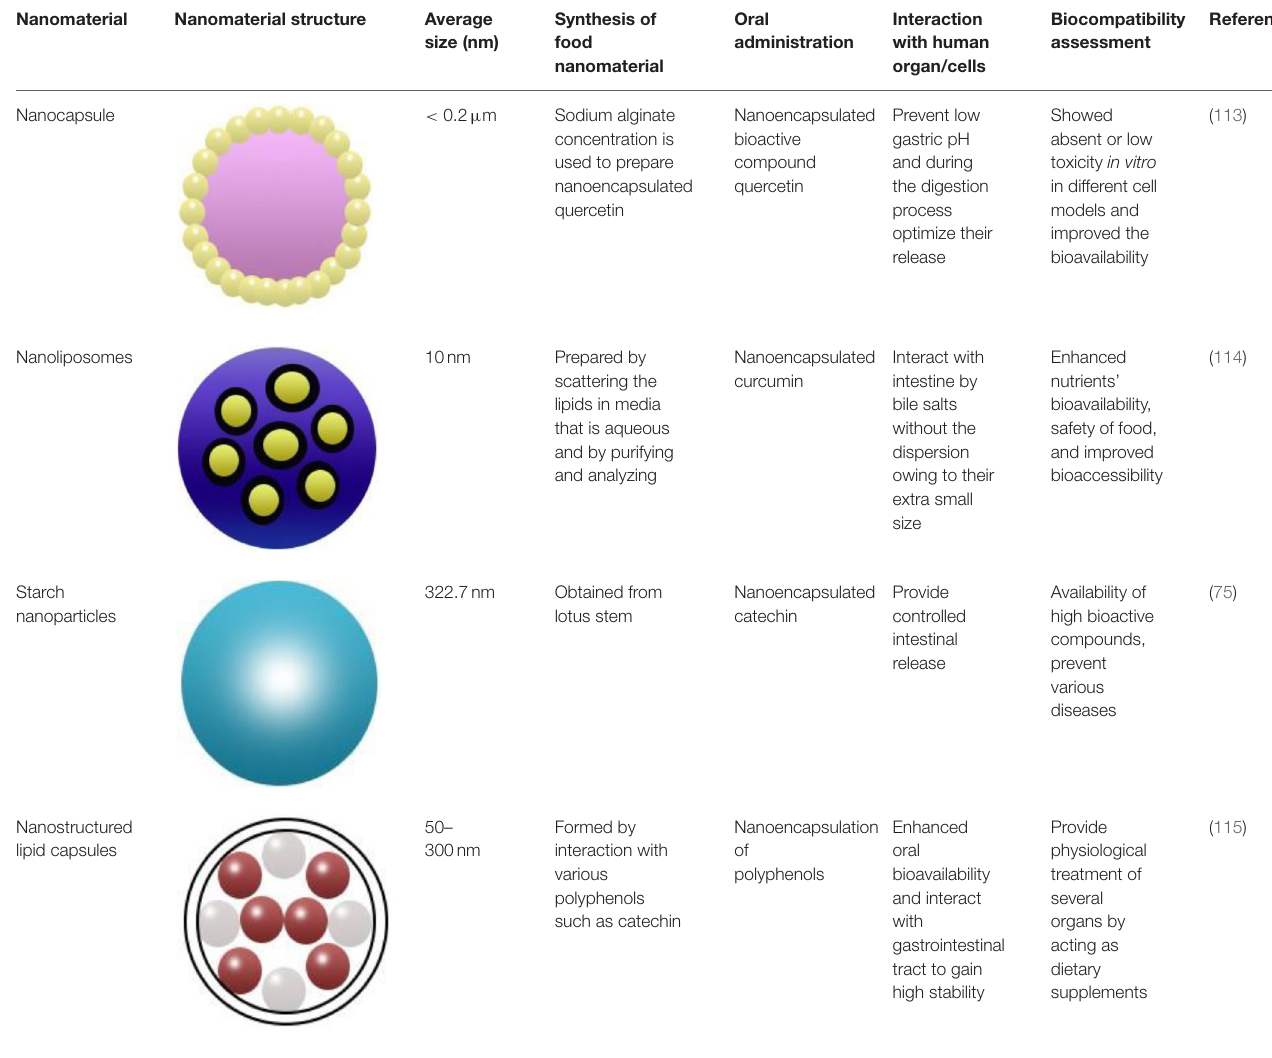
TABLE 2 | Comprehensive insight to the bioactive component’s retention and bioavailability of